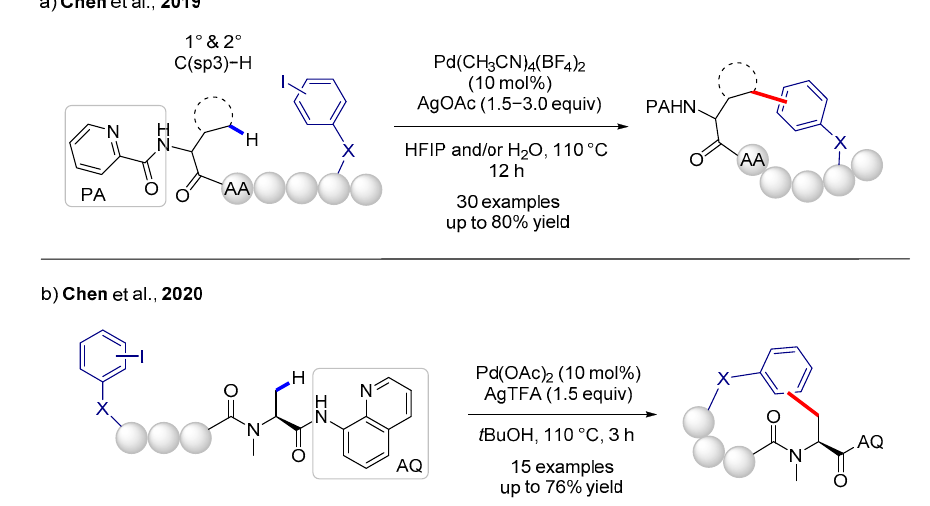
Figure 21. Synthesis of cyclophane-braced peptide macrocycles via intramolecular C(sp 3 )–H arylation [87,88].